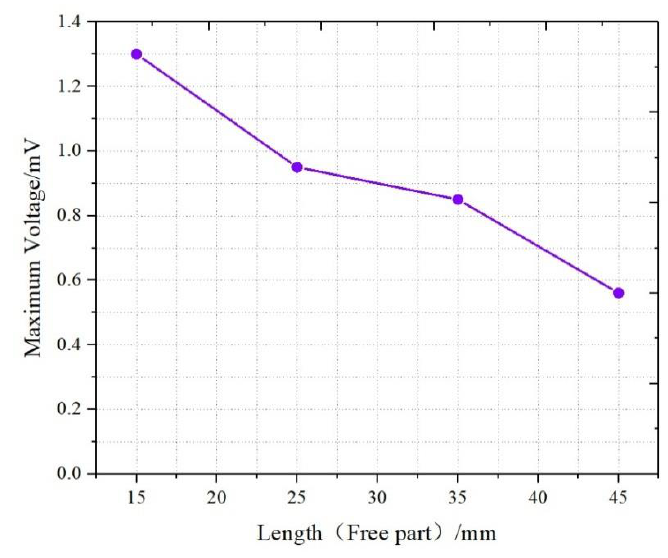
Figure 10. Signals of different lengths (Free part).